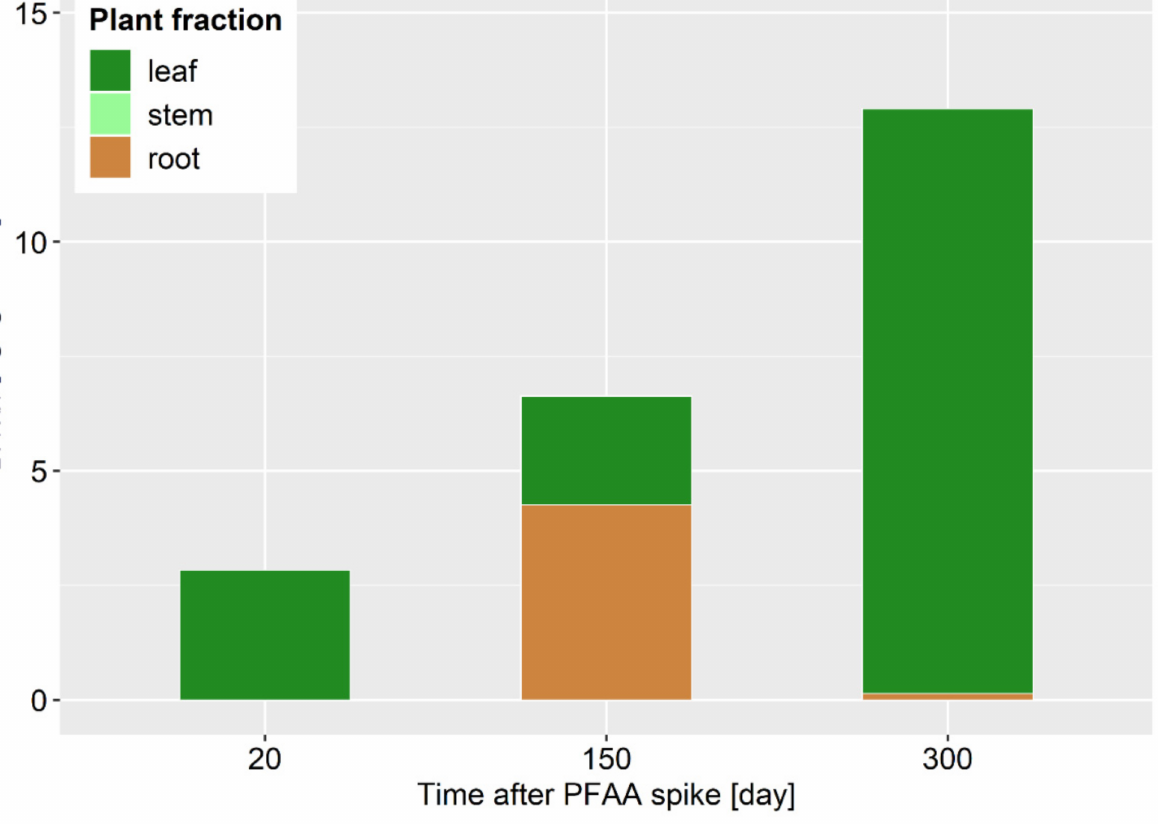
Figure 5. PFAA concentration in plants (ng g − 1 ww) harvested about 20 days (t 20 ), 5 months (t 150 ) and 10 months (t 300 ) “after PFAA spike” in the tank. Different colours represent Σ PFAA levels in each part of the plant: root (brown), stem (dark green) and leaf (light